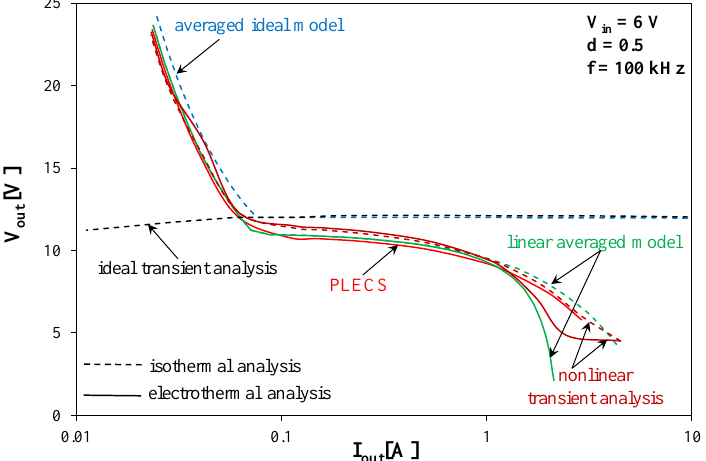
Figure 6. Computed dependences of the converter output voltage on its output current at V in = 6 V.